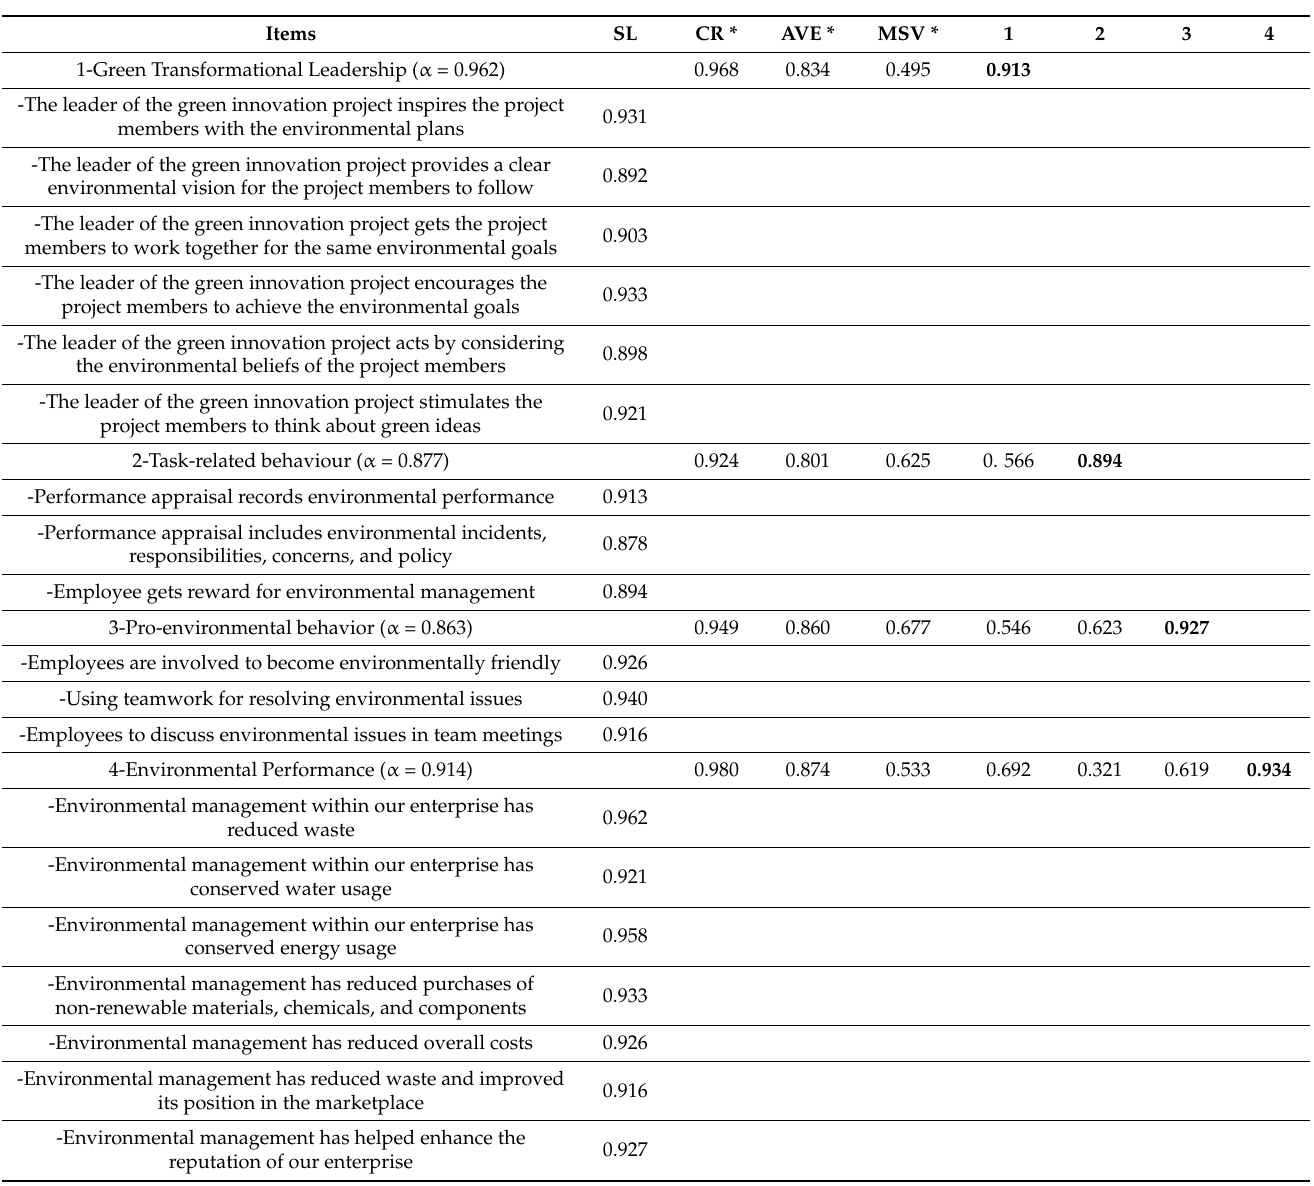
Table 3. Convergent and discriminant validity (developed by